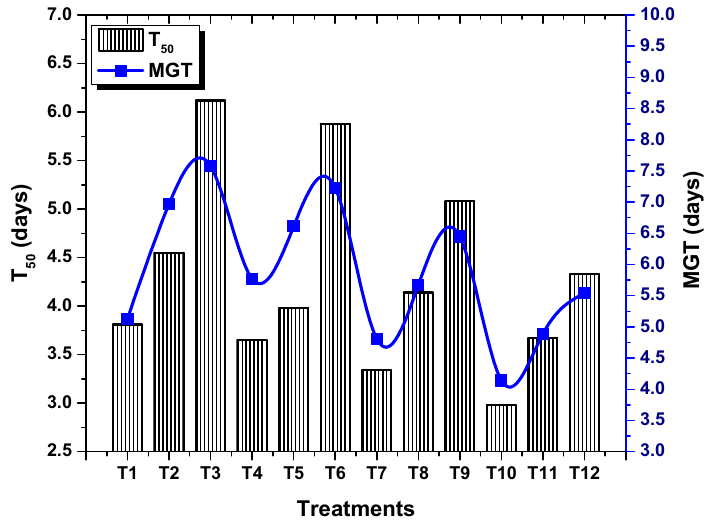
Figure 4. Effect of TU–ANPs on mean germination time ( MGT ) and time to 50% germination ( T 50) of Zea mays under various levels of NaCl-based osmotic stress.